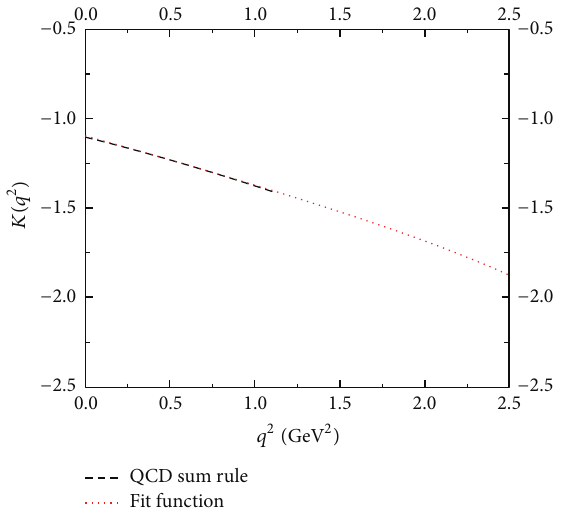
Figure 2: 𝐾(𝑞 2 ) as a function of 𝑞 2 at 𝑀 2 = 10 GeV 2 and 𝑀 󸀠2 = 6.5 GeV 2 .